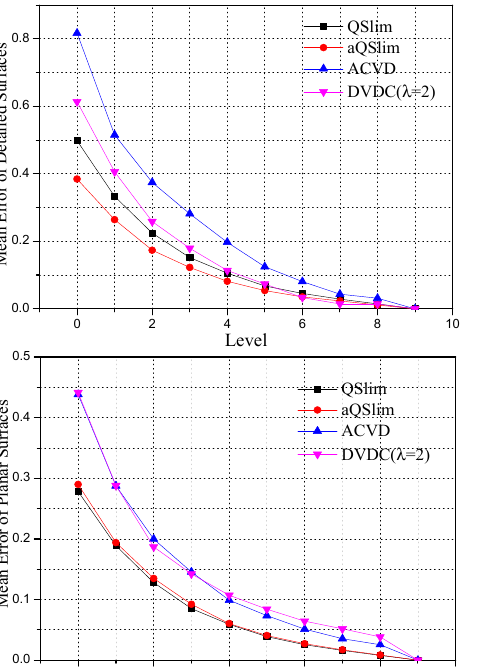
Figure 12. Comprehensive mean error measured by Metro. QSlim and aQSlim appear to perform much better than the other two simplification algorithms. The difference between QSlim and aQSlim fails to be represented in terms of comprehensive error. ( a ) Scenery 1; ( b ) Scenery 2.